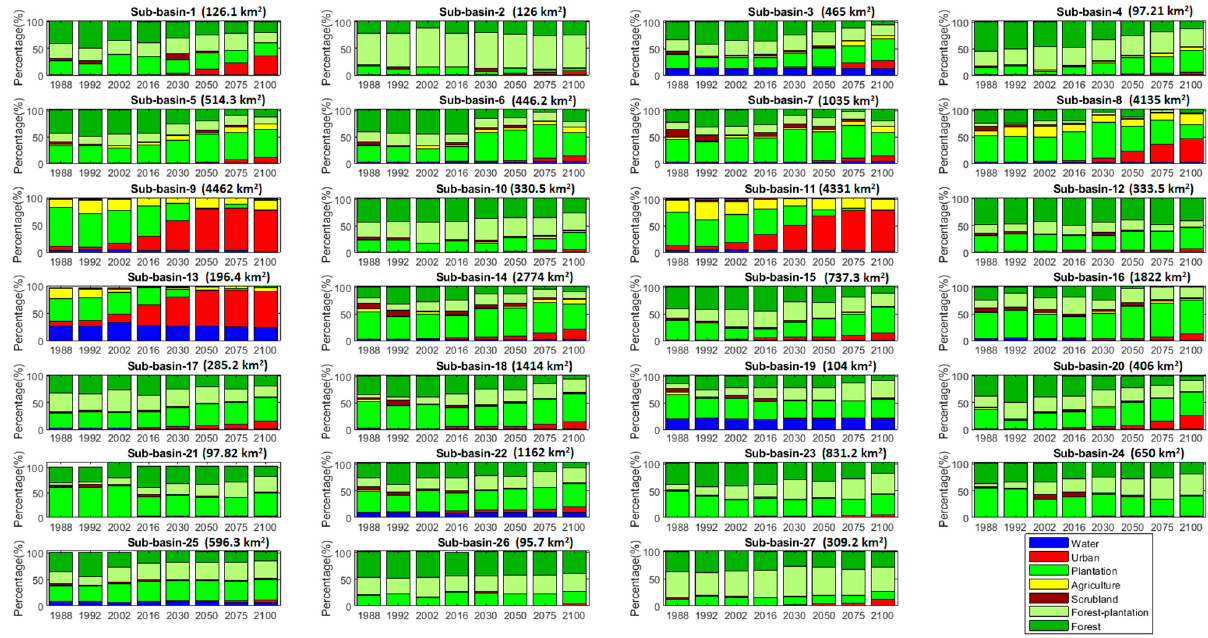
Figure 3. LULC change (%) in sub-basins of PRW for the years 1988, 1992, 2002, 2016, 2030, 2050, 2075, and 2100.